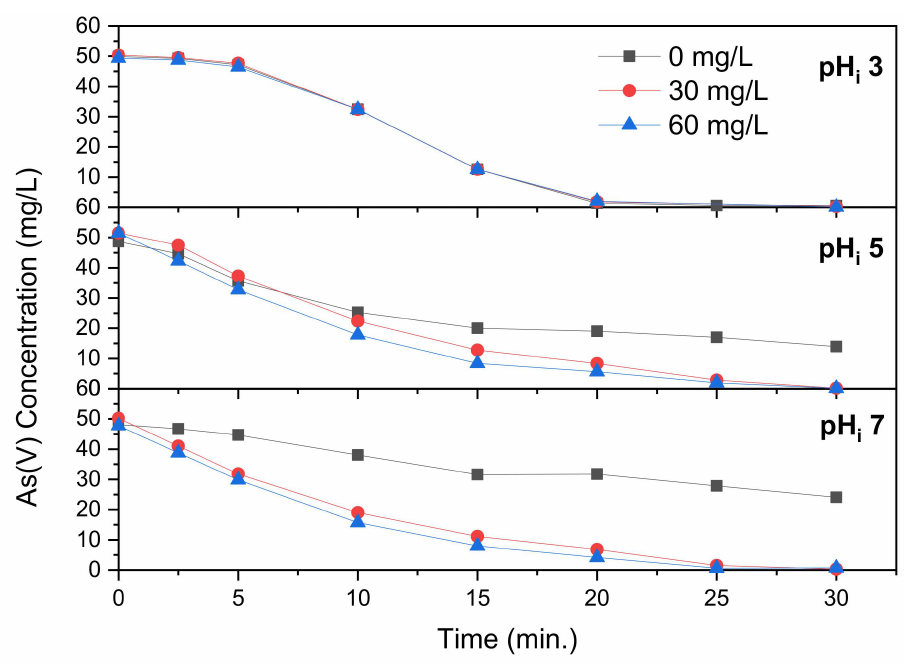
Figure 7. Arsenic removal over time through electrocoagulation assisted by varying concentrations of Ca(II) addition.